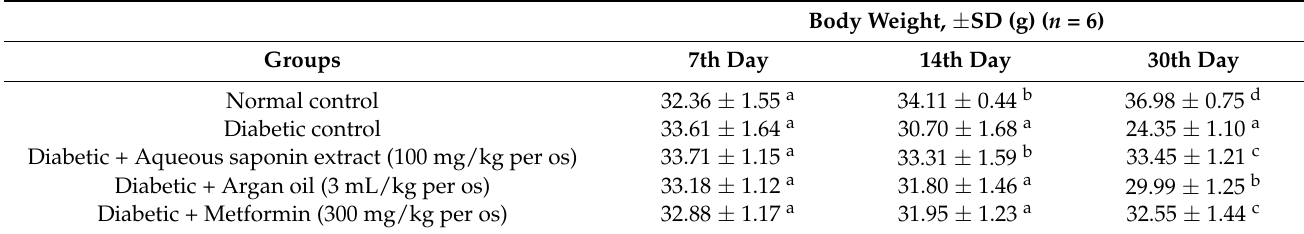
Table 6. The average body weight of mice in the different groups.